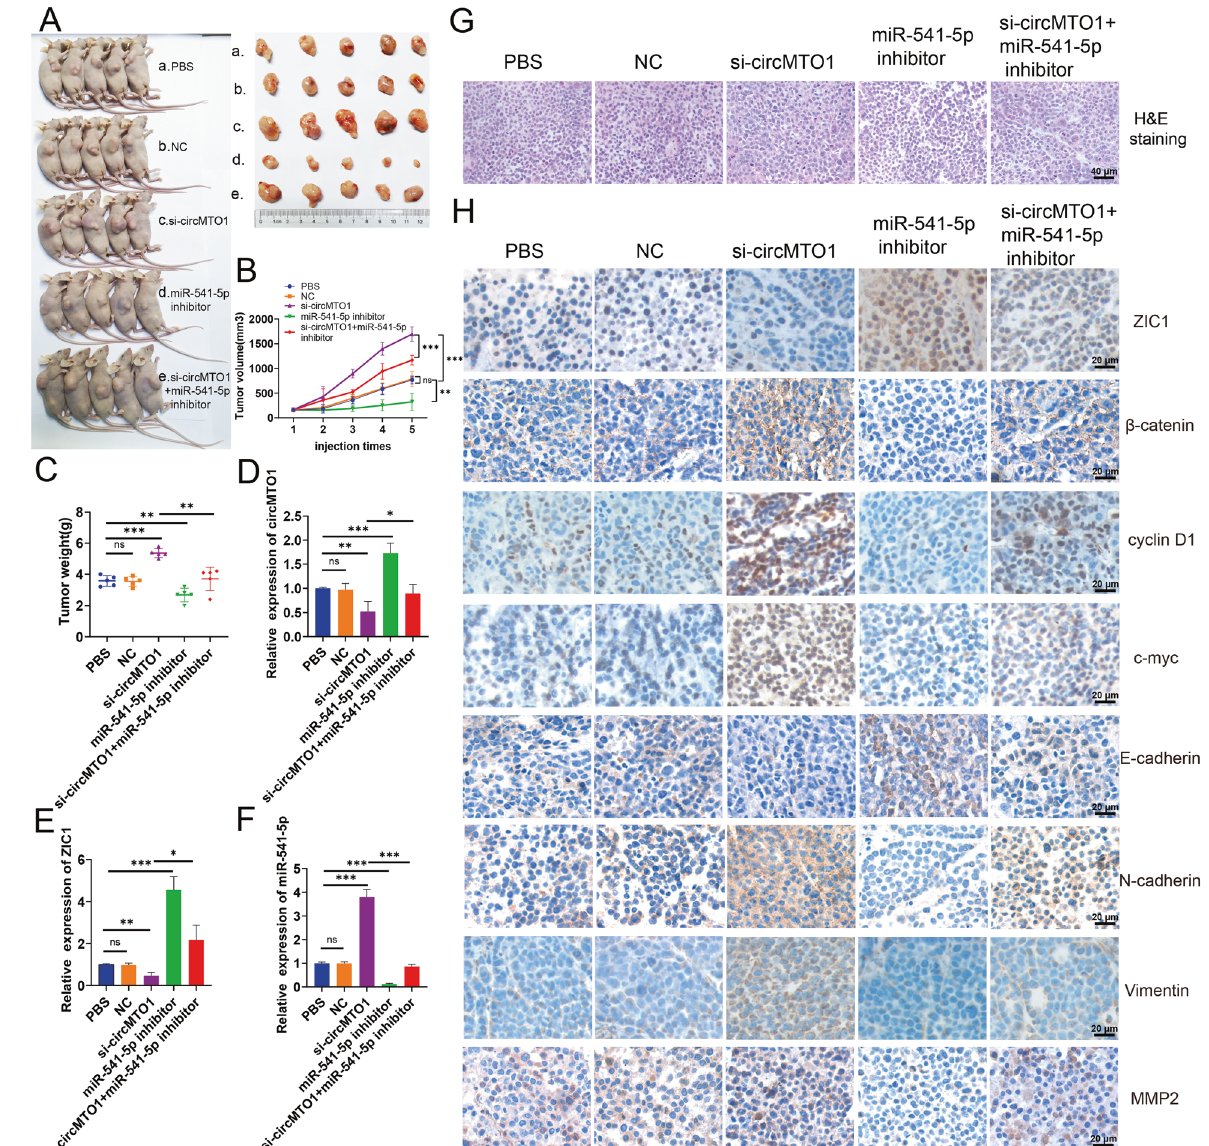
Fig. 8 CircMTO1/miR-541-5p/ZIC1 axis inhibited HCC tumor growth in vivo. A Nude mice were subcutaneously injected with (a.) PBS, (b.) cholesterol-conjugated negative control (NC), (c.) cholesterol-conjugated si-circMTO1, (d.) cholesterol-conjugated inhibitor (e.) cholesterol- conjugated si-circMTO1 + cholesterol-conjugated inhibitor. After fi ve injections, tumors were dissected and imaged. B Before injection, the tumor volume was measured and the tumor growth curve plotted. C Tumor weight was calculated on the day the mice were killed. Data represents mean ± SD ( n = 5 per group). D – F Expression levels of circMTO1, miR-541-5p, and ZIC1 in xenograft tumors were measured using RT-qPCR. G H&E staining revealed the structure of xenograft tumors. Scale bar; 40 μ m. H Changes in ZIC1, β -catenin, c-myc, cyclin D1,